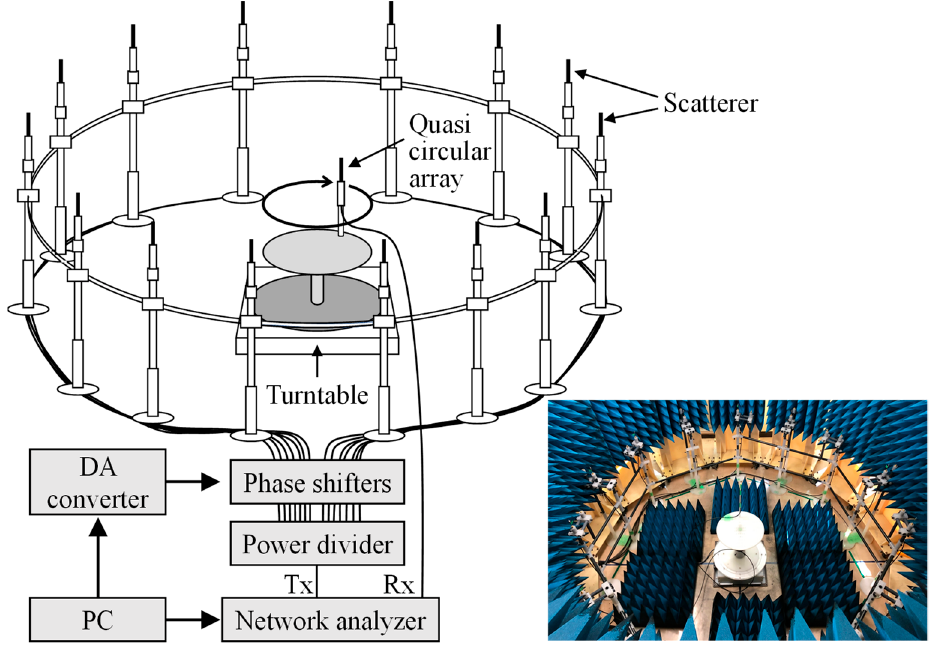
Figure 5. Configuration of the massive MIMO-OTA apparatus.